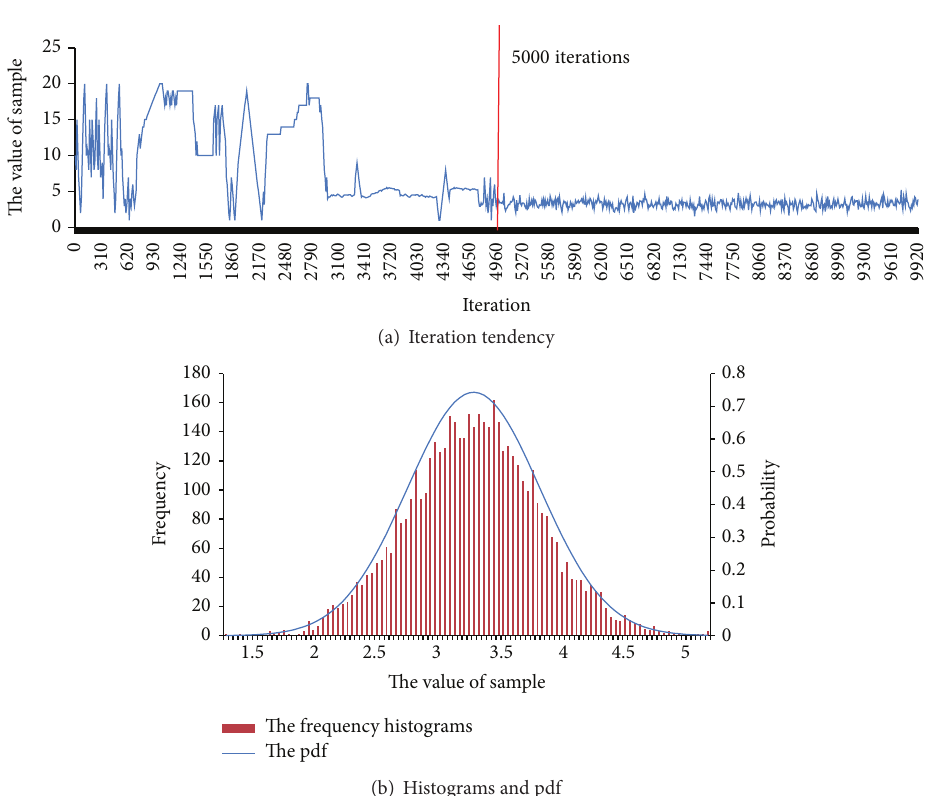
Figure 5: An example for statistical analysis on the samples of the